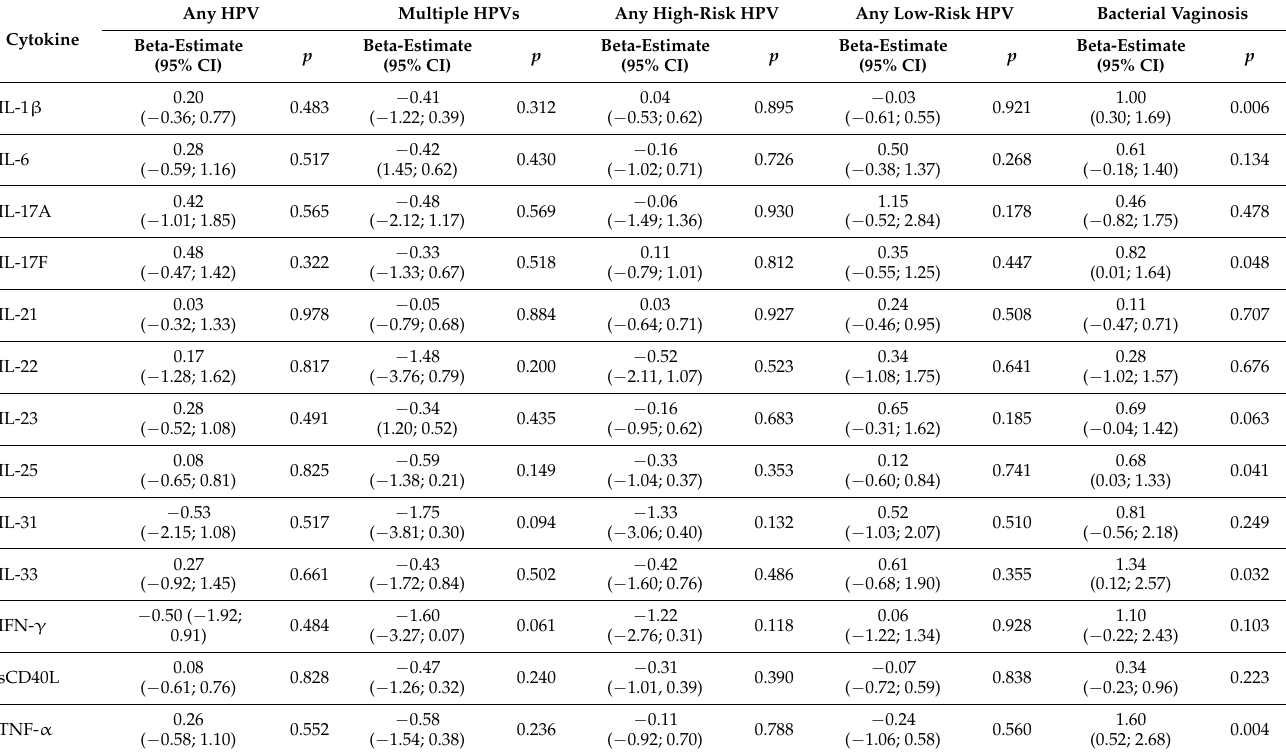
Table 3. Mixed effect logistic regression to identify associations between having any HPV, multiple HPVs, any high-risk HPVs, or any low-risk HPVs and cervicovaginal